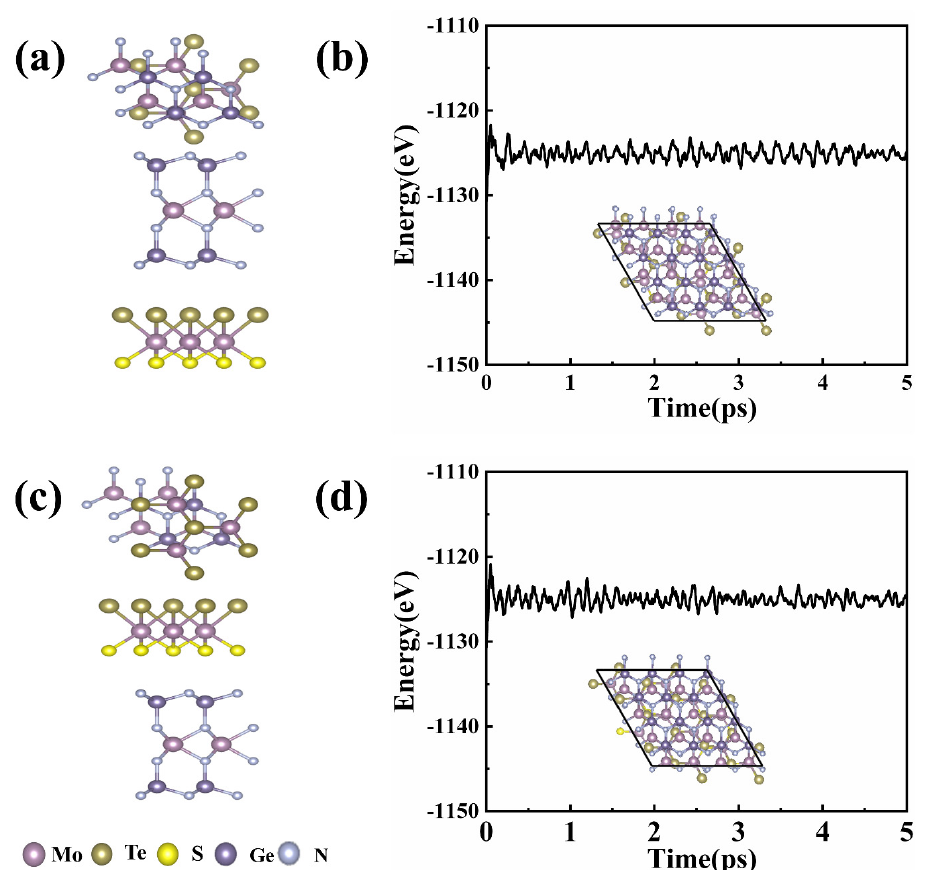
Figure 1. Top and side views of the optimized atomic structures of ( a ) Te 4 –MoSTe/MoGe 2 N 4 vdWH and ( b ) S 4 –MoSTe/MoGe 2 N 4 vdWH. The AIMD results are shown in ( c ) Te 4 –MoSTe/MoGe 2 N 4 vdWH and ( d ) S 4 –MoSTe/MoGe 2 N 4 vdWH, and the insets show the crystal structure at the end state.